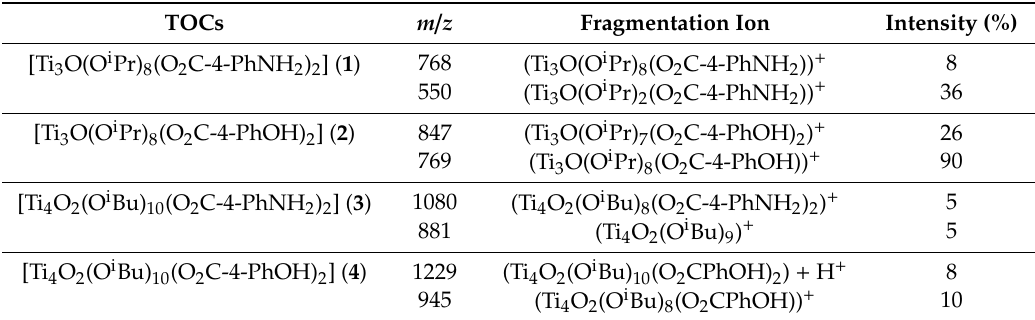
Table 3. The results of electrospray ionization-mass spectrometry (ESI-MS) spectra studies of the ( 1 )–( 4 ) complexes. TOCs: tetranuclear oxo-titanium(IV) complexes.